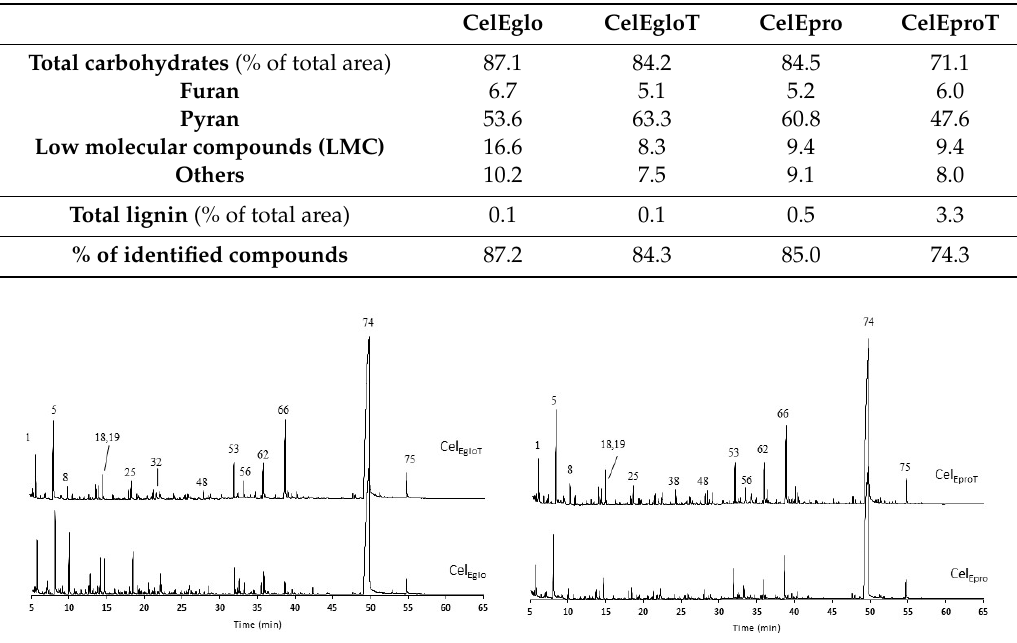
Figure 5. Pyrograms of the celluloses from E. globulus and E. propinqua before (CelEglo, CelEpro) and after the thermal treatment (CelEgloT, CelEproT). Peak identification: 1—2-oxo-propanal; 5—hydroxyacetaldehyde;